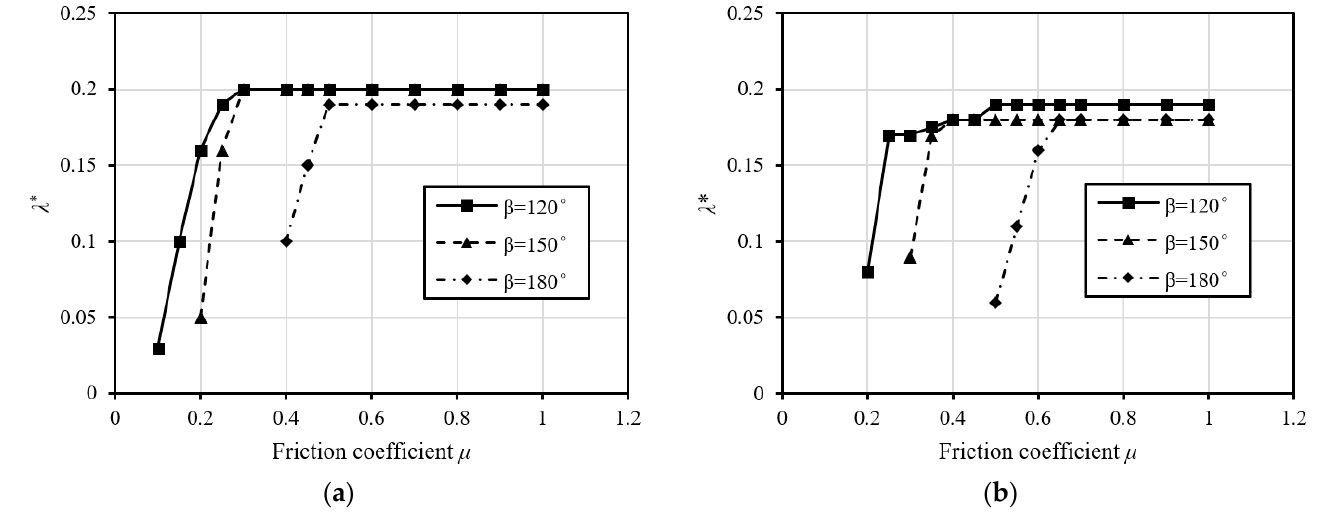
Figure 19. Variation of λ * against μ : ( a ) circular arch; ( b ) basket-handle arch. As it is shown, for small friction, i.e., µ ≤ 0.5, λ * increases significantly with the increase of µ . However, after µ reaches some thresholds, λ * becomes constant, i.e., it is barely affected by the friction coefficient. This can be attributed to the change of failure modes. If µ is below the threshold, the sliding failure will occur, as shown in Figure